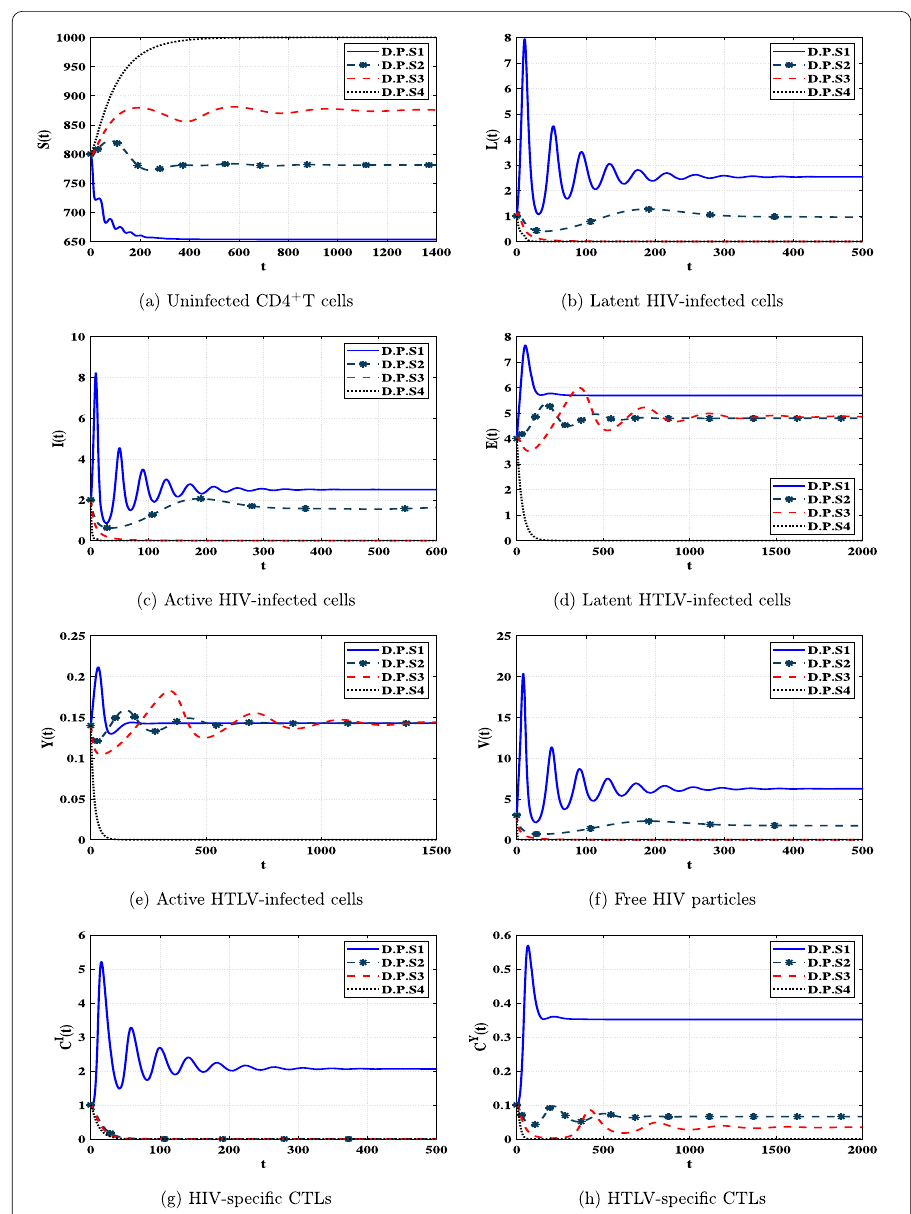
Figure 9 Impact of delay parameters (cid:26) i , i = 1,2, ... ,6, on the behavior of solution trajectories of system